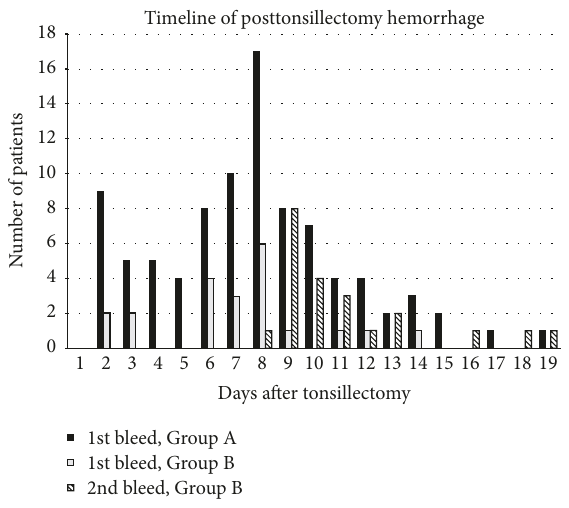
Figure1:Summaryofnumberofpatientswhobledoneachdayafter tonsillectomy.